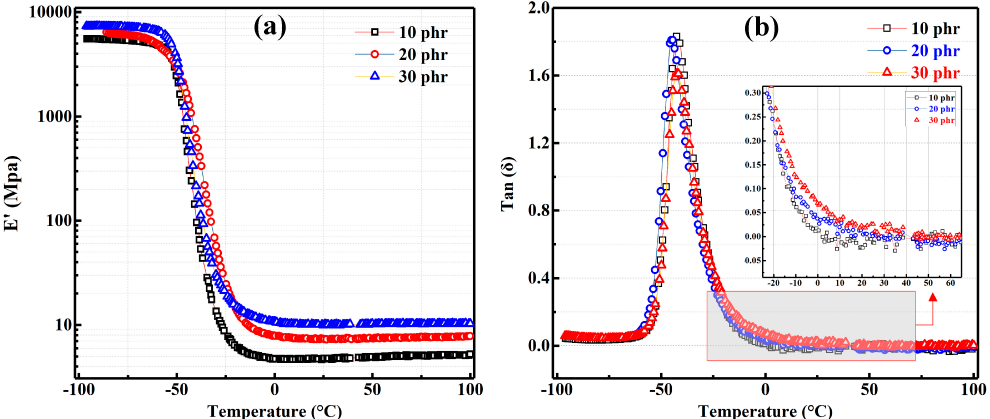
Figure 10. DMA measurement of the mFD/NR composites with different content of mFD. ( a ) storage modulus (E’) and ( b ) loss factor (tan δ ) of the composites as a function of temperature.